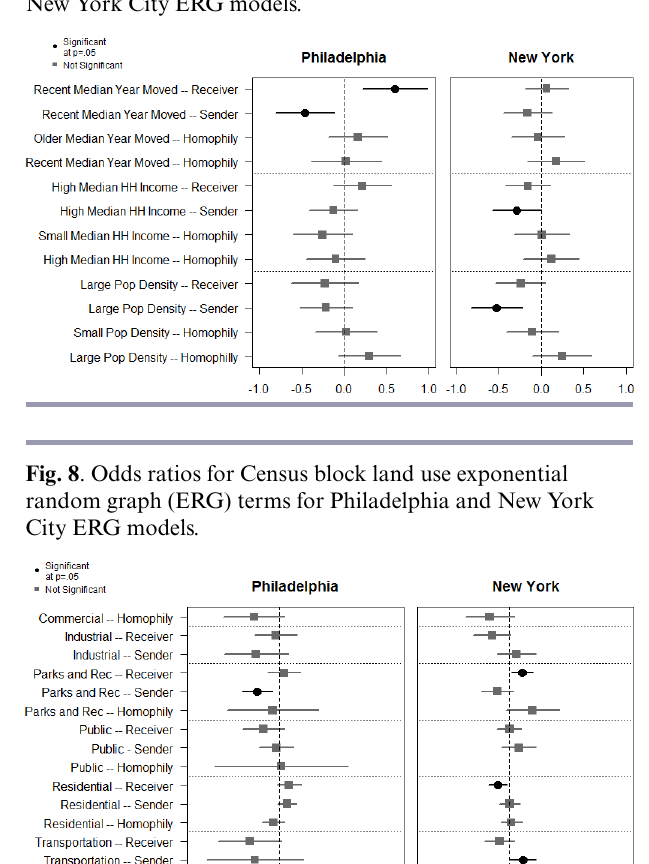
Fig. 7 . Odds ratios for ACS Census block data for home office exponential random graph (ERG) terms for Philadelphia and New York City ERG models.